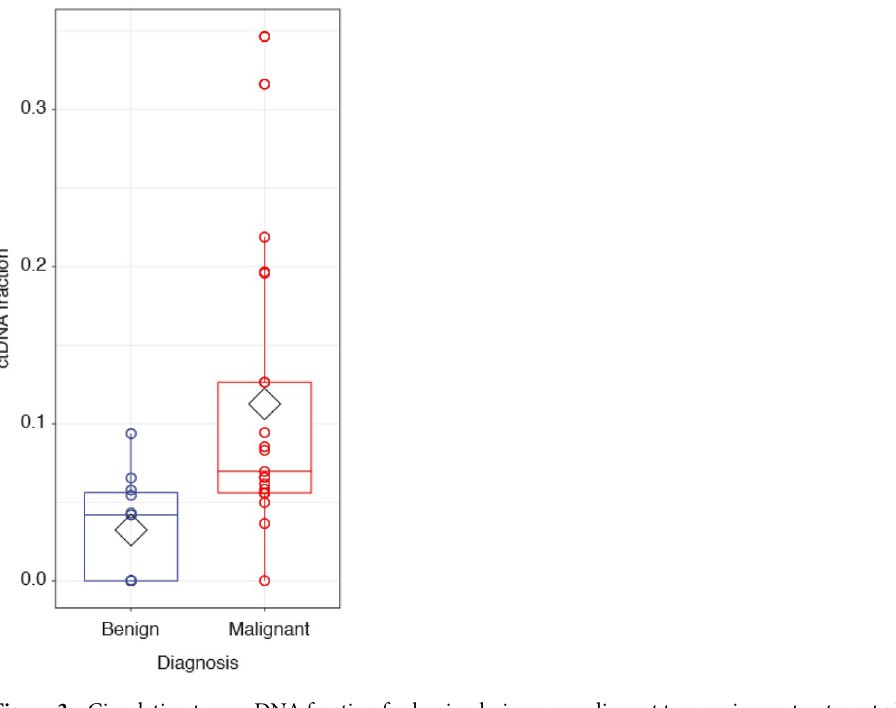
Figure 3. Circulating tumor DNA fraction for benign lesions vs malignant tumors in pre-treatment plasma samples ( p = 0.001). Means are represented by diamonds for each